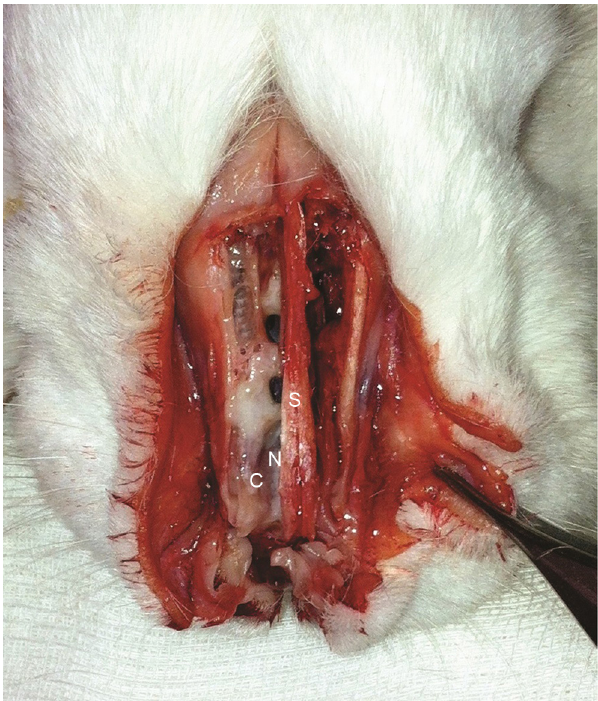
Figure 1 Outer wall of the open sinonasal cavities, exposing the maxillary sinuses and nasal cavity. Evident infectious pro- cess on the right, characterized by mucosal edema and purulent discharge. Anatomical sites represented by the maxillary sinus (M), nasal septum (S), inferior turbinate (T), and nasal cavity (N). was evaluated according to its intensity, classified as absent, present, or severe (Figs. 2 and 3).